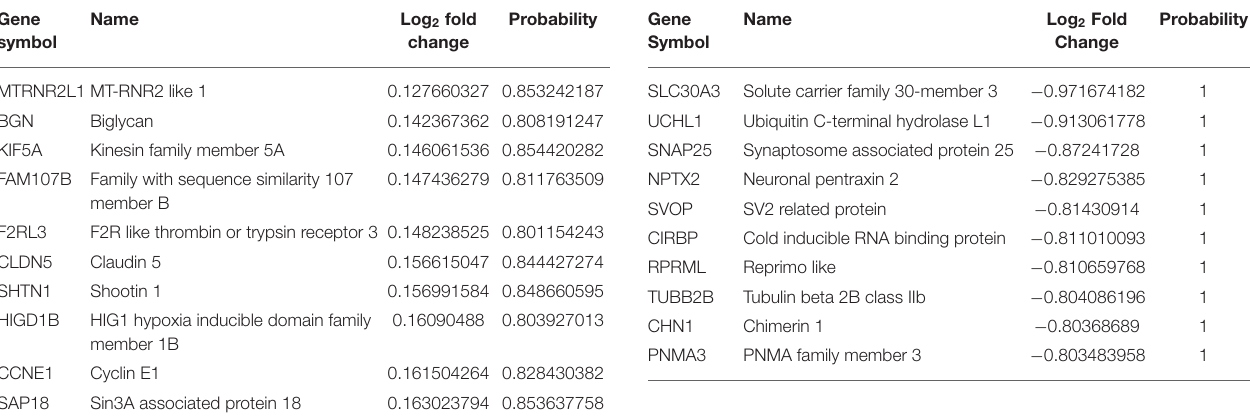
TABLE 4 | The top 10 downregulated genes in AD vs. asymptomatic samples.